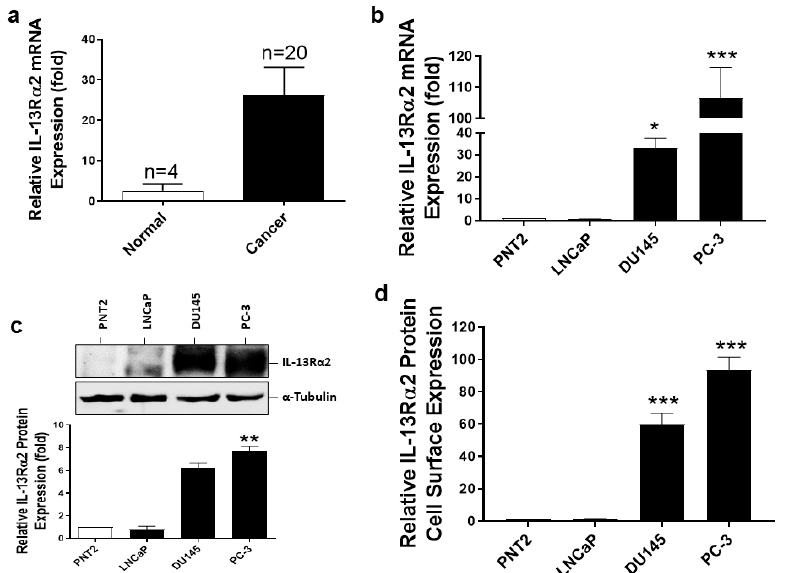
Figure 1. Expression of IL-13R α 2 in prostate tissues and cell lines. ( a ) Relative-fold change in expression of IL-13R α 2 mRNA in normal and cancerous tissues. ( b ) Real-time PCR (RT-PCR) analysis of IL-13R α 2 mRNA expression in non-cancer and cancer cell lines. ( c ) Western blot analysis of IL- 13R α 2 protein expression in PNT2, LNCaP, DU145 and PC-3 cells. Quantification of IL-13R α 2 protein expression was performed via densitometric analysis of the bands and normalising to housekeeping protein ( α -Tubulin) expression. ( d ) Cell surface expression of IL-13R α 2 protein was assessed by subjecting non-permeabilised cells to ELISA. All Western blots and RT-PCR values are normalised to housekeeping controls. The data are mean ± SEM values of three independent exper-